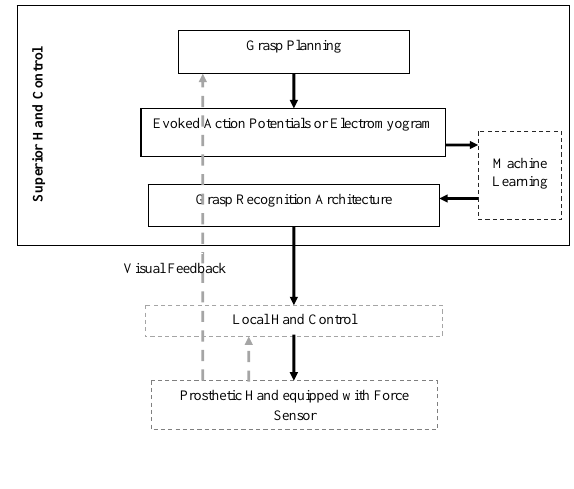
Figure 3. Schematic of Superior Hand Control